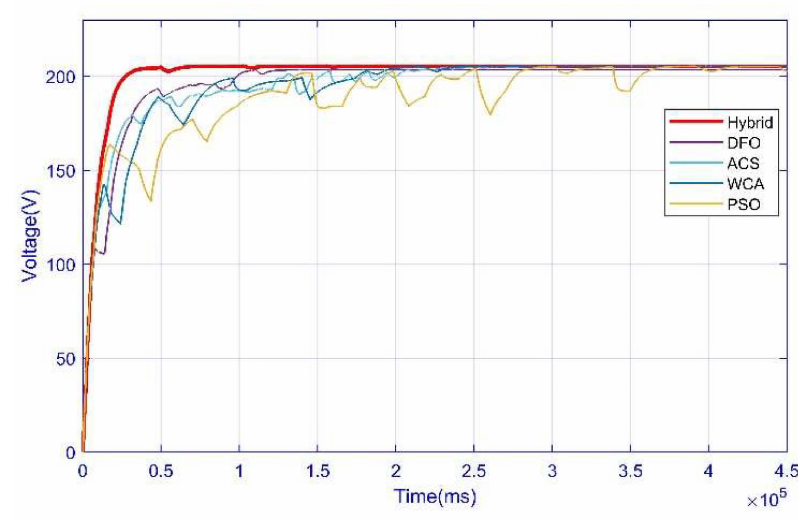
Figure 10. Case 2: Voltage comparison of hybrid with other techniques.